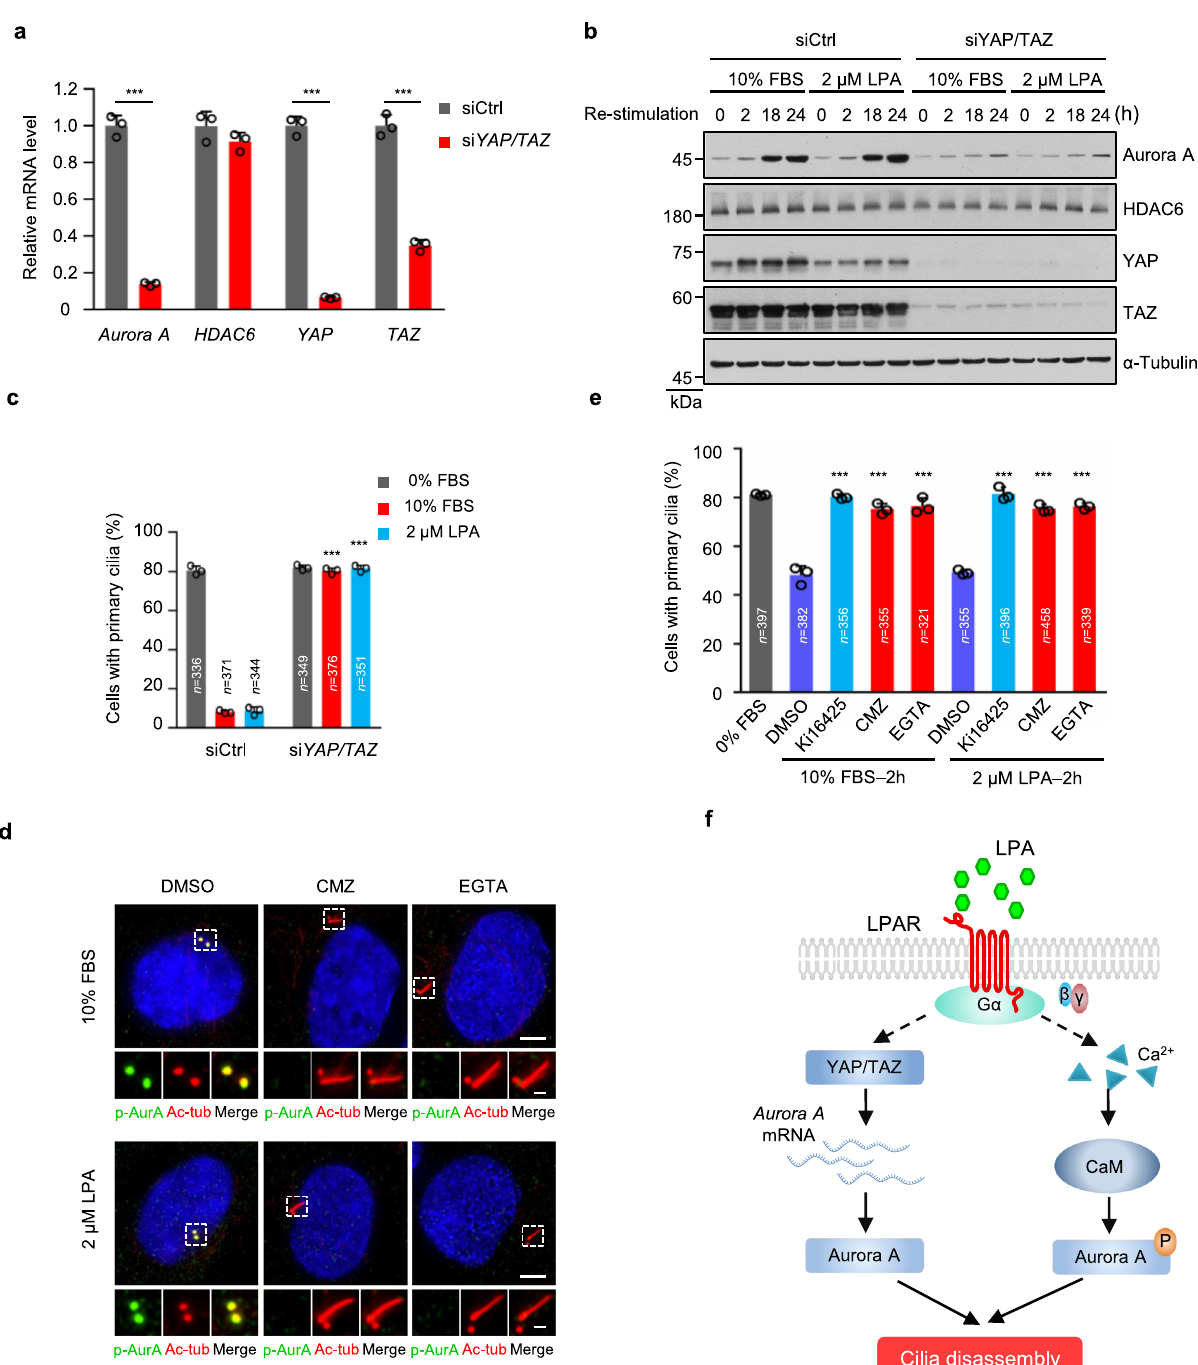
Fig. 4 LPA signaling modulates Aurora A through YAP/TAZ and calcium/CaM pathway. a YAP/TAZ is required for the LPA-induced the transcription of Aurora A . RPE-1 cells were starved for 12 h and then transfected with control siRNA or YAP/TAZ siRNAs. Following serum starvation for another 48 h, cells were treated with 2 μ M LPA for 18 h, and the mRNA levels were measured by qPCR. b Immunoblot analysis in control or YAP/TAZ knockdown cells using indicating antibodies. RPE-1 cells were transfected and treated as described in Fig. 3f. c The effect of serum- or LPA-induced cilia disassembly in control or YAP/TAZ knockdown cells. RPE-1 cells were transfected and treated as described in Fig. 2b, c. d CMZ or EGTA blocks serum- and LPA- induced Aurora A activation. Ciliated RPE-1 cells were pretreated with CMZ (5 μ M), EGTA (0.5 mM) or DMSO control for 30 min, and then cells were stimulated with 10% FBS or 2 μ M LPA for 2 h. Cells were stained with anti-p-AurA (Aurora A, green), anti-Ac-tub (Ac-tubulin, red) antibodies. Scale bar: 5 μ m (main image) and 1 μ m (magni fi ed region). e CMZ or EGTA blocks serum- and LPA- induced cilia disassembly. Ciliated RPE-1 cells were pretreated with Ki16425 (40 μ M), CMZ (5 μ M), EGTA (0.5 mM) or DMSO control for 30 min, and then cells were stimulated with 10% FBS or 2 μ M LPA for 2 h. f A proposed model for LPA signaling in the regulation of cilia disassembly. Source data are provided as a Source Data fi le. Three experiments were repeated independently with similar results in b and d . Data are presented as mean ± S.D. of three independent experiments in a , c , and e . n , number of cells. *** P < 0.001. Two-tailed Student ’ s t -test in a , two-way ANOVA test was performed followed by Dunnett ’ s multiple comparisons in c and e .